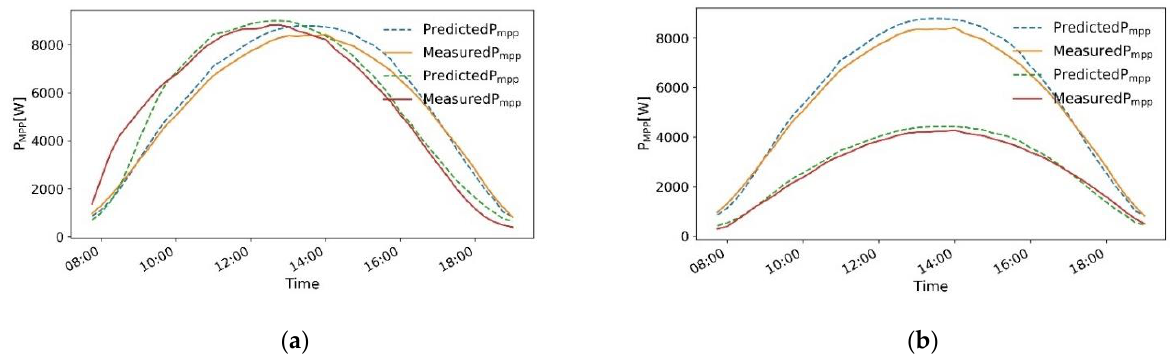
Figure 6. Measured and predicted values for 16 April 2019: ( a ) MPPT 1 for inverters 2U01 and 2U04; ( b ) MPPTs 1 and 2 for inverter 2U01.